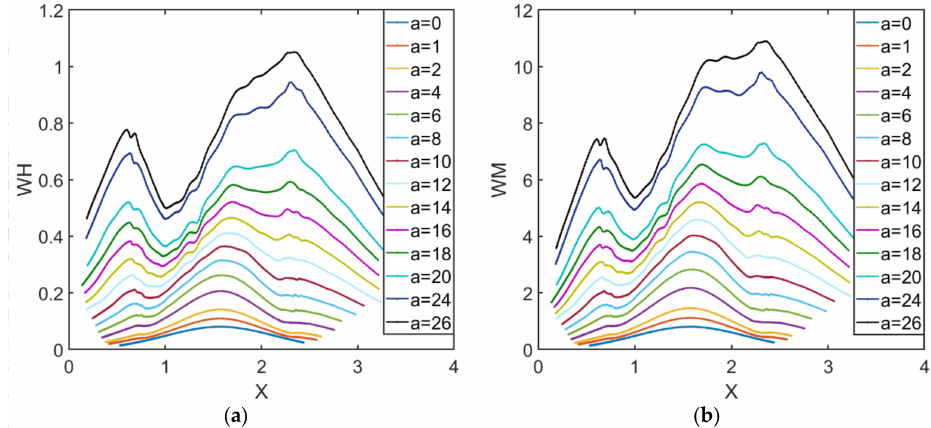
Figure 4. The WH and WM curves obtained using the improved Suter transform: ( a ) WH curve; and ( b ) WM